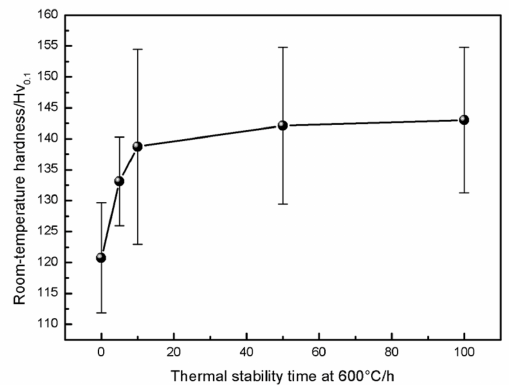
Figure 9. Effect of the thermal stabilization time on room temperature hardness of the CuAl seal